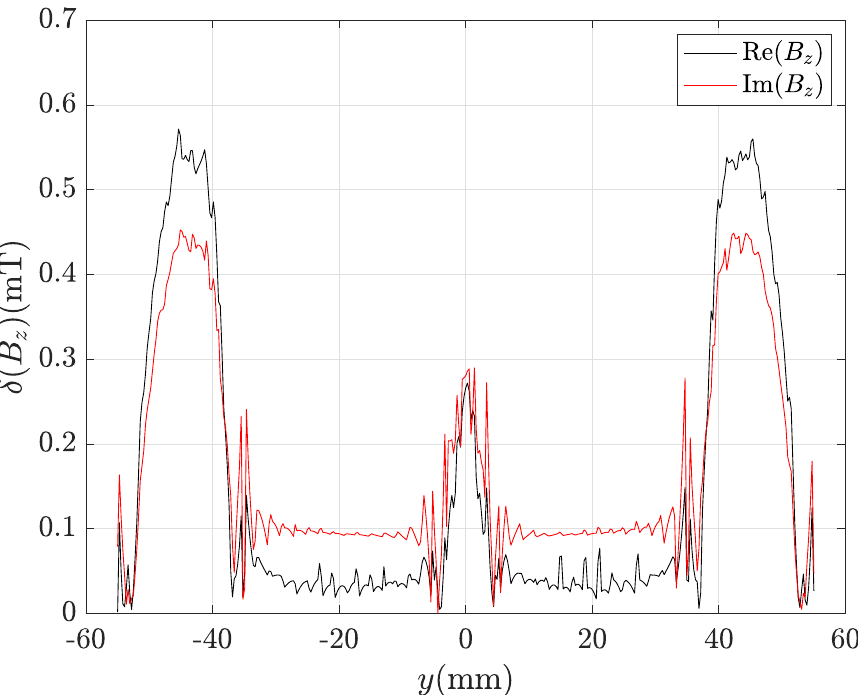
Figure 18. Local discrepancy between CM-BEM and FEM profiles of component B z in Figure 16.